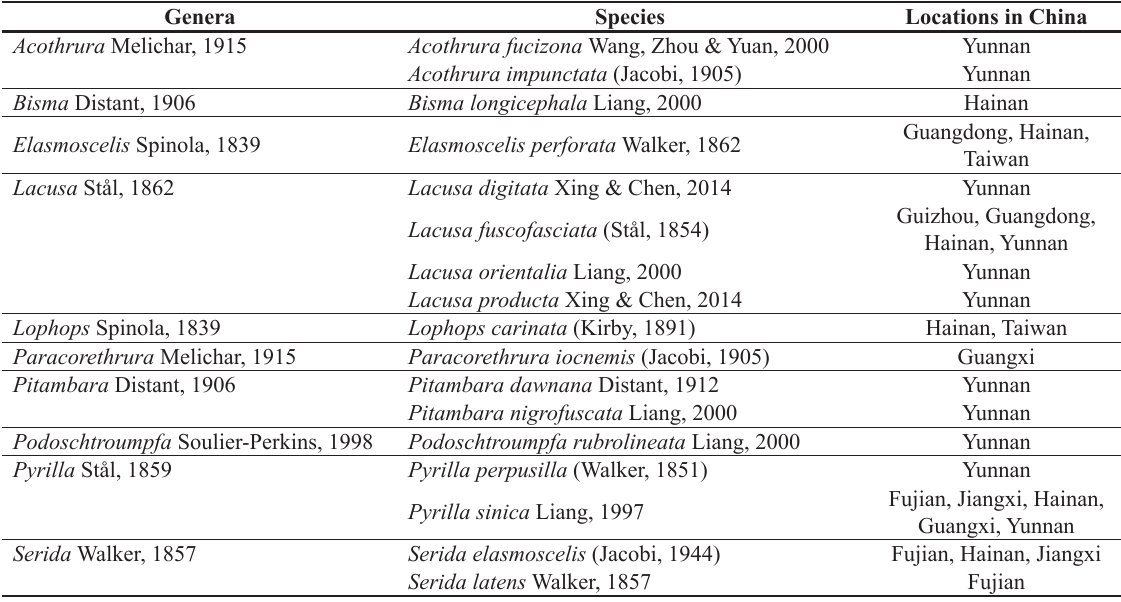
Table 1. Known Lophopidae species in